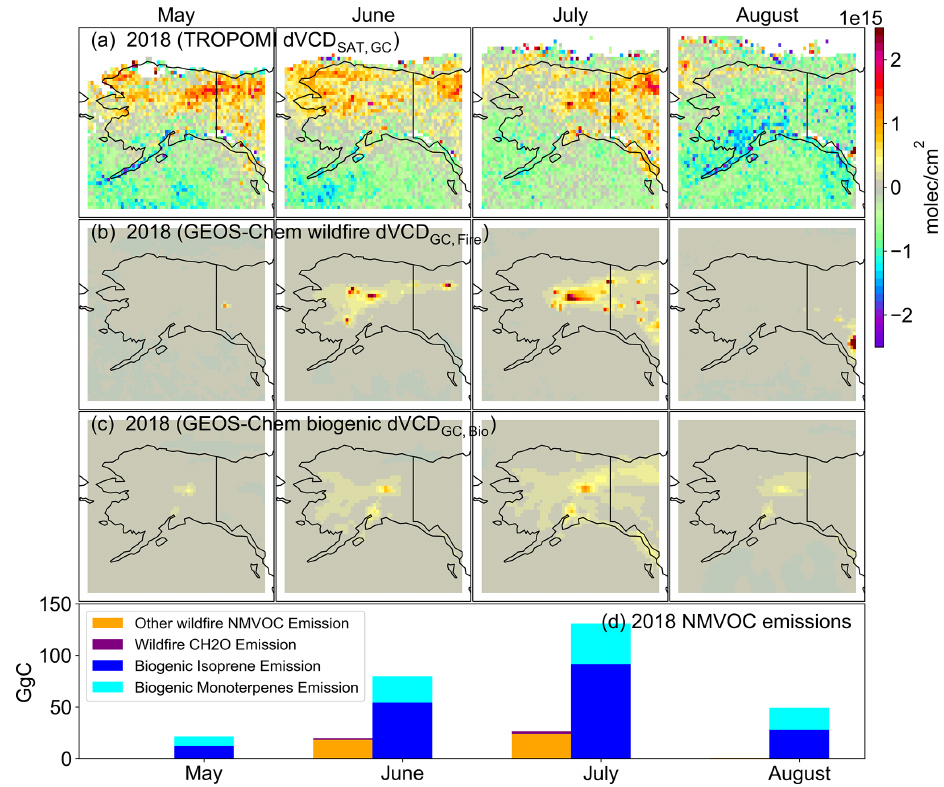
Figure 3. dVCD and emission in Alaska in summer 2018. Panels (a) are reprocessed TROPOMI monthly HCHO dVCD SAT , GC in May, June, July and August (unit: moleculescm − 2 ). Panels (b) are GEOS-Chem wildfire emission-induced monthly dVCD GC , Fire . Panels (c) are GEOS-Chem biogenic emission-induced monthly dVCD GC , Bio . Panel (d) is the total NMVOC carbon emission from terrestrial vegetation and biomass burning in Alaska each month (unit: GgC); blue bars are biogenic isoprene emissions, cyan bars are biogenic monoterpenes emissions, purple bars represent wildfire direct HCHO emissions and orange bars represent other NMVOCs emitted by wildfires.